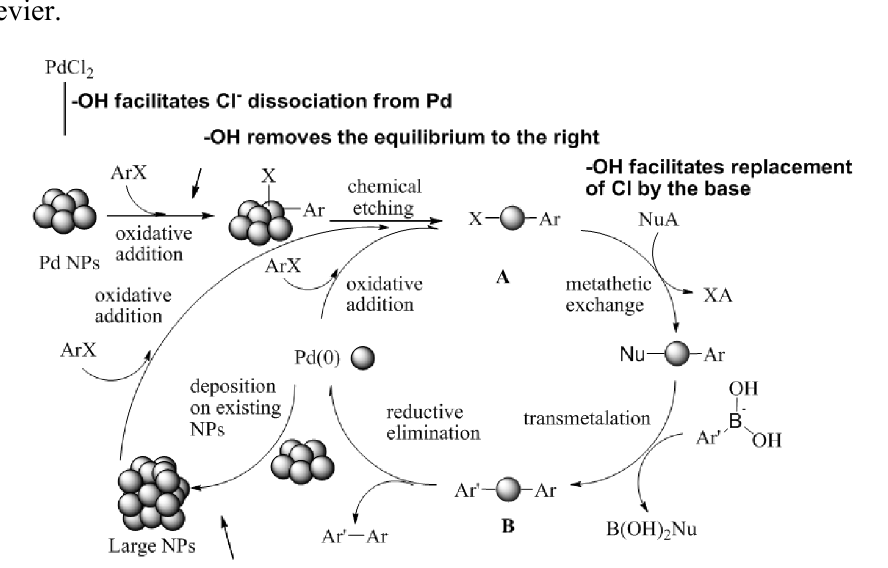
Figure 2. The proposed catalytic cycle for Suzuki coupling and the roles of a hydroxyl group functionalized IL in the catalytic system. Reprinted from Ref. [26], with permission from